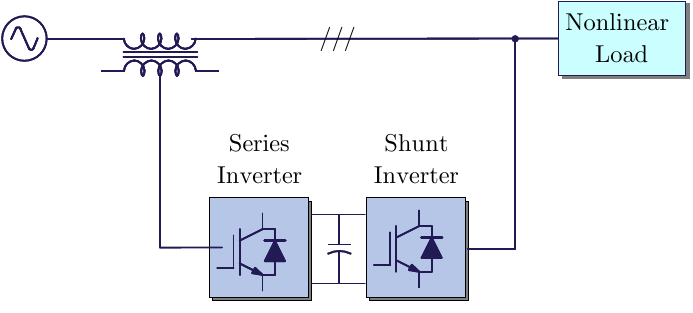
Figure 1. Structure of the Unified Power Quality Conditioner (UPQC).